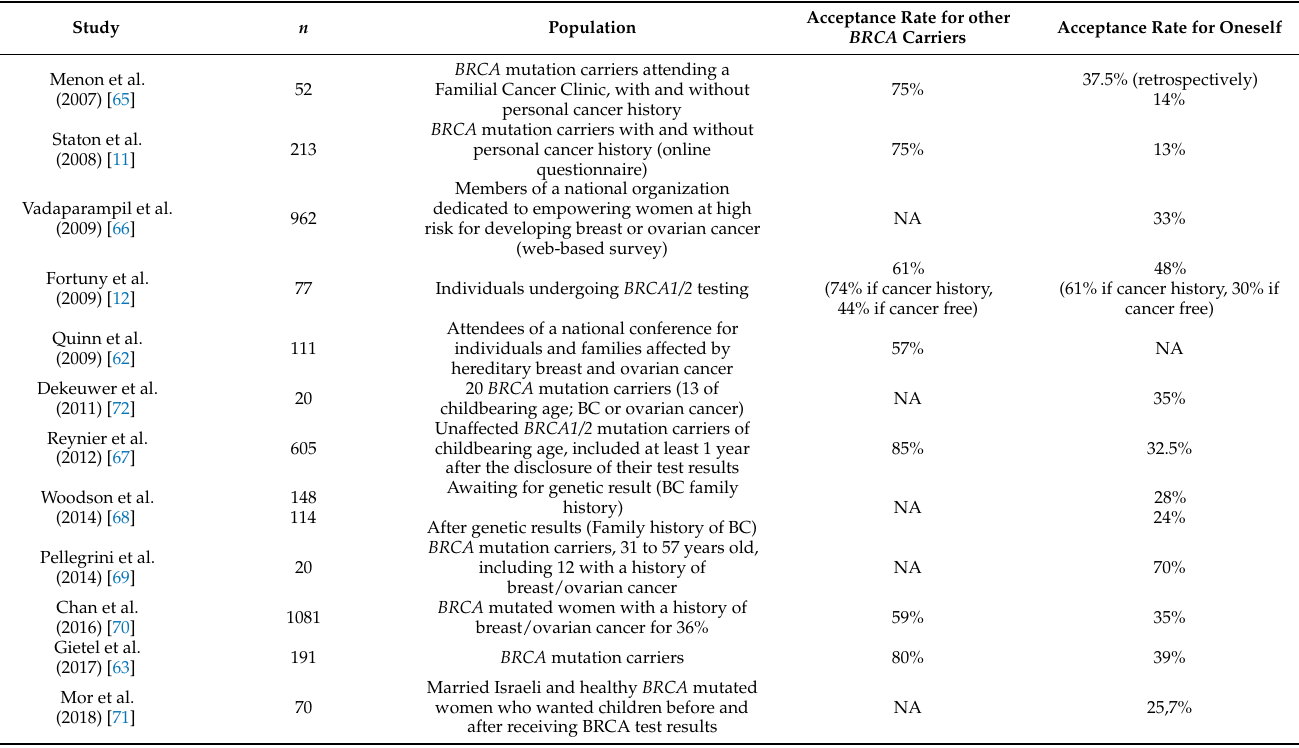
Table 3. Rates of BRCA related PGT acceptance rates in medical